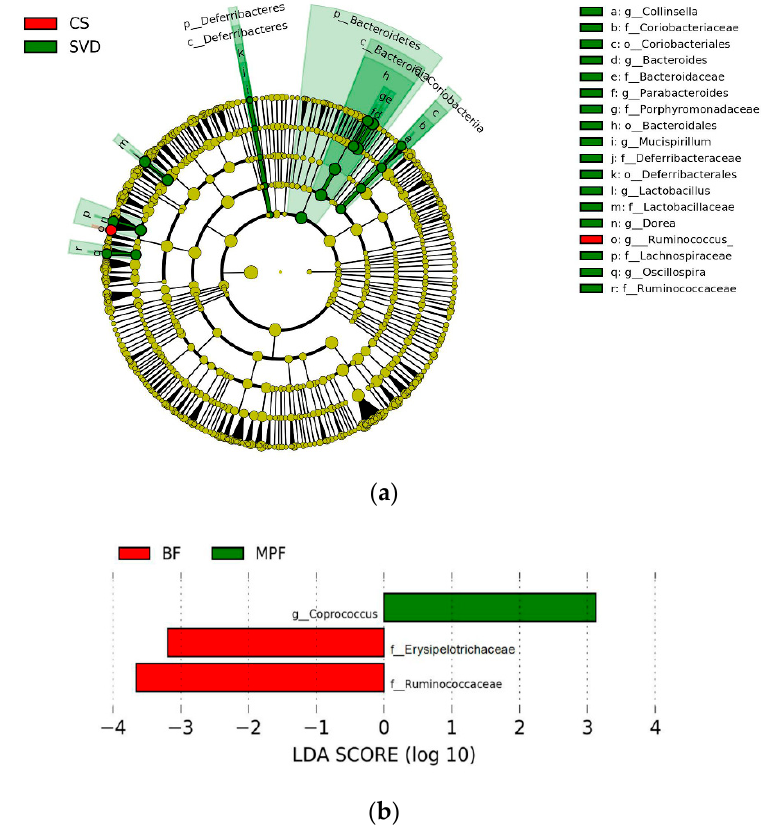
Figure 5. Linear discriminant analysis (LDA) effect size (LEfSe) analysis of infant gut microbiota in different delivery modes and feeding methods. ( a ) Delivery modes (alpha value = 0.01, LDA score = 3.0); ( b ) Feeding methods (alpha value = 0.05; LDA score = 2.0).